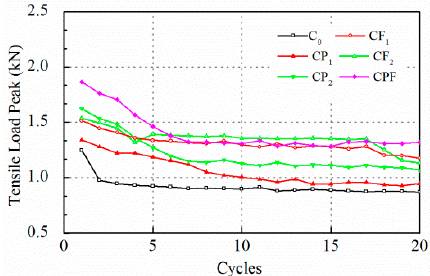
Figure 11. Tensile load peak at 0.1 mm crack opening for the first 20 runs.